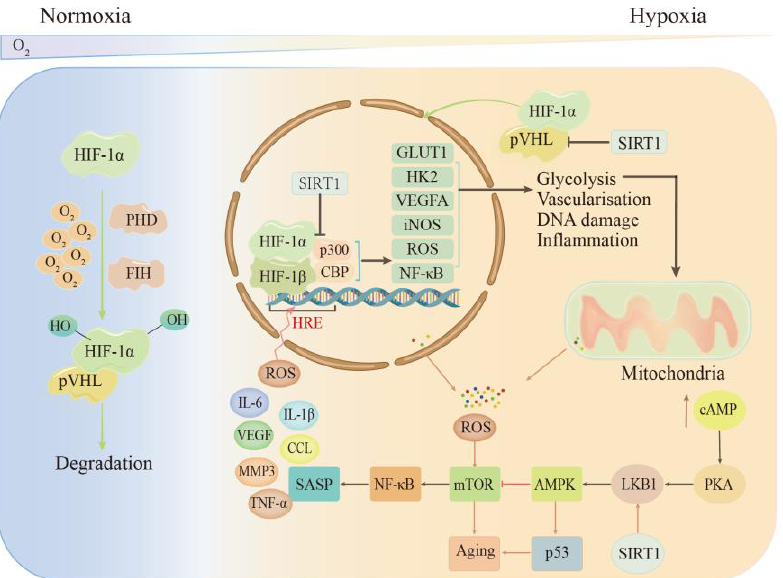
Figure 1. Regulation of HIF- 1α under hypoxic conditions . Under normoxia, HIF- 1α is inhibited by PHD and FIH and cannot bind to HIF- 1β. Hypoxia binds to HIF - 1β and recruits p300 or CBP to respond adaptively to hypoxia, inducing the expression of many genes such as GLUT1 and HK2, thus promoting glycolysis to produce energy and also stimulating angiogenesis and DNA damage. Intracellular cAMP levels increase after sustained hypoxia, and cAMP and senescence act through signaling pathways such as AMPK-mTOR, ultimately producing SASP to play a physiological role.